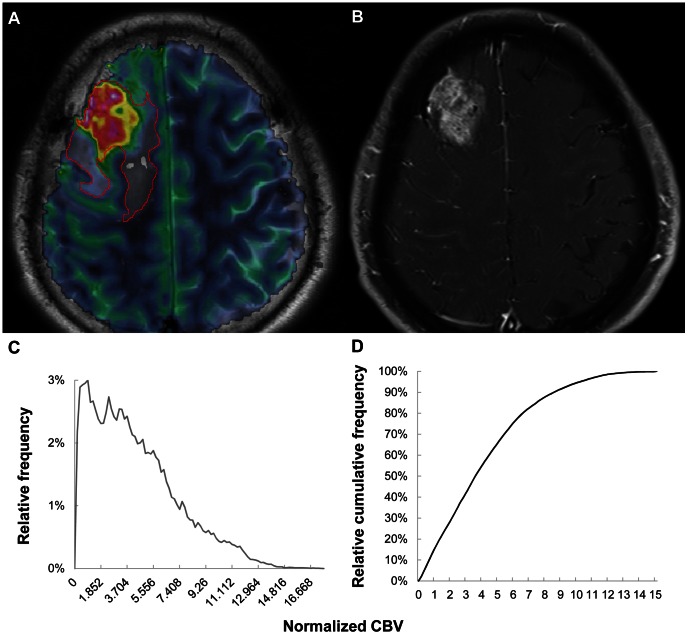
Images of a 50-year-old female with a grade IV glioblastoma.(A) ROI-drawn rCBV map overlaid on a T2-weighted image, (B) contrast-enhanced T1-weighted image, (C) histogram of nCBV and (D) cumulative nCBV histogram. The 99th percentile value of the cumulative nCBV histogram was 12.489. ROI = region of interest; rCBV = relative CBV; nCBV = normalized CBV.